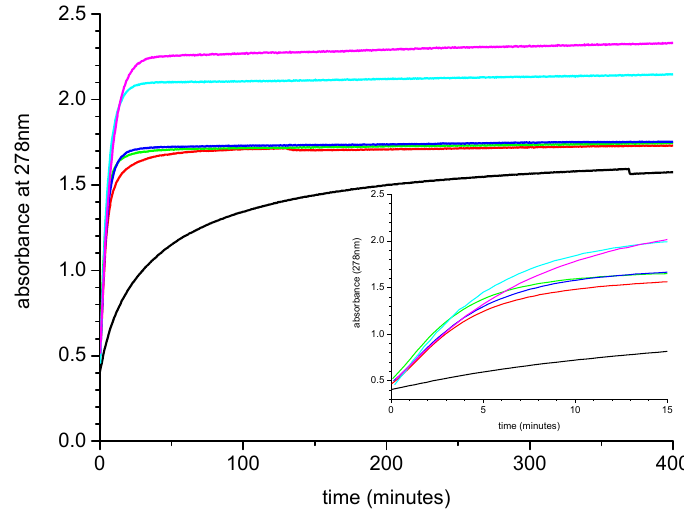
Figure 4. Examples of the absorbance at 278 nm recorded during the homocoupling reaction of 150 μ M 1 in pH 9 aqueous borate buffer (10 mM) and catalyst Pd ‐ PPy ‐ PS (1.8 μ M Pd) over the course of 7 h at 70 °C in the presence of 0 M (black), 0.05 M (red), 0.1 M (green), 0.25 M (blue), 0.5 M (cyan), and 1 M (magenta) NaBr with the first 15 min of the reaction as inset.